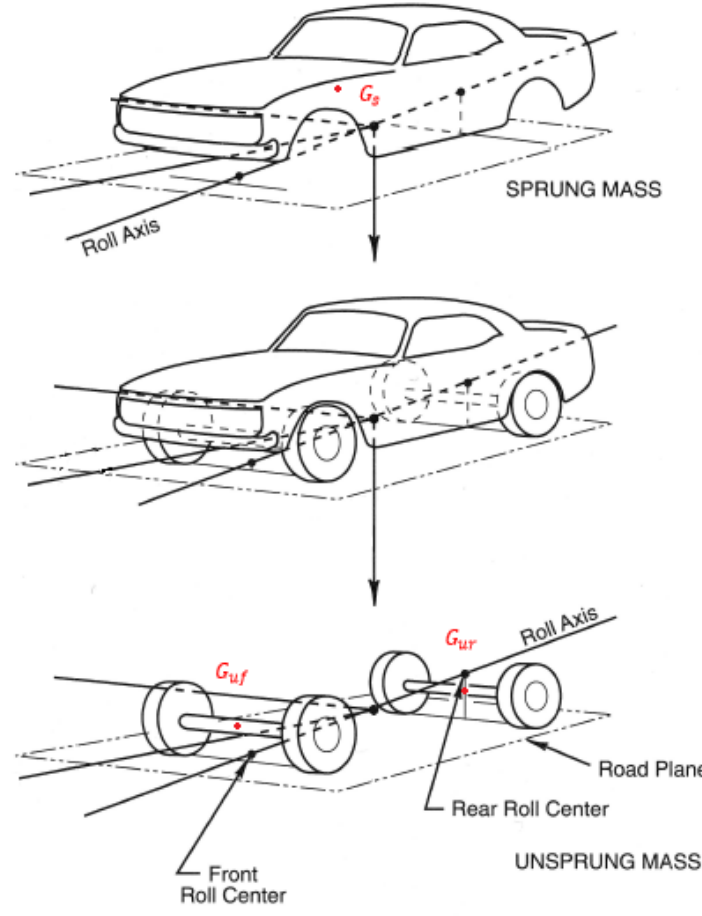
Figure 2. The sprung and unsprung masses decomposition.